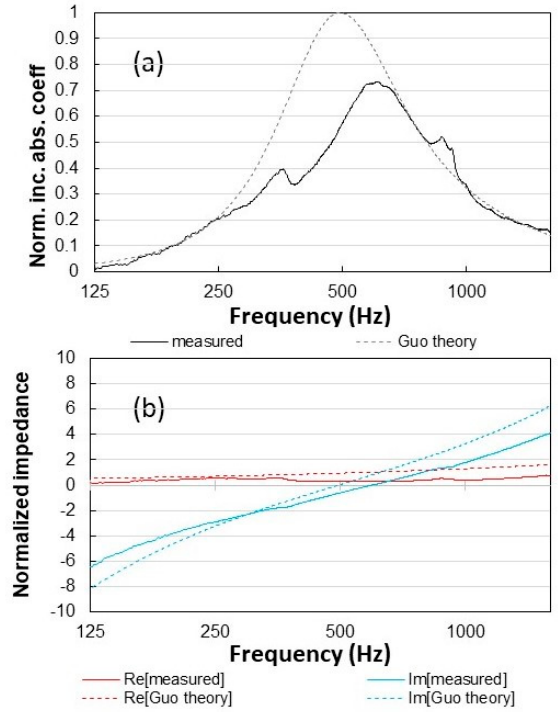
Figure 7. Comparison of the measured (solid line) and calculated (dashed line) values of the normal absorption coefficient ( a ) and specific impedance ( b ) of Specimen #1, with an air-back cavity of 50 mm depth.